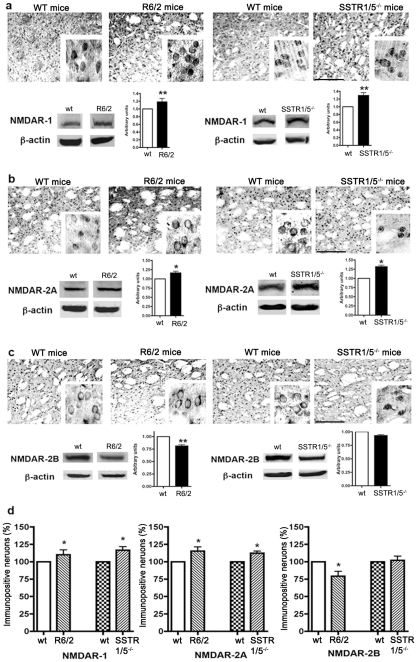
Representative photomicrographs illustrating distribution of NMDAR subtypes expression in striatum of R6/2 and SSTR1/5−/− mice.Comprarable distribution pattern of NR1 (a), NR2A (b) and NR2B (c) was seen between R6/2 mice and SSTR1/5−/− mice. Quantitaive analysis of receptor immunoreactivity was accomplished using Western blot analysis. Note the increased expression of NR1 (120 kDa) immunoreactivity (a upper panel) and expression by Western blot (a lower panel) in R6/2 and SSTR1/5−/− mice. NR2A (180 kDa) expression was increased in R6/2 and SSTR1/5−/− mice (b). Decreased expression of NR2B (190 kDa) was seen in R6/2 mice whereas no significant changes in SSTR1/5−/− mice when compared to wt mice (c). Note cytosolic accumulation of NR2A and NR2B in SSTR1/5−/− mice and membrane expression in R6/2 mice. Percentage changes in NMDARs positive neurons in R6/2, SSTR1/5−/− mice and wt mice are shown in panel (d). Data presented as mean ± SD for Western blot analysis (SSTR1/5−/−, n = 5 and R6/2 mice, n = 3) in comparison to wt mice brain, *P<0.05, ** P<0.01. Scale bar = 20 µm panel a–c and 5 µm for inset.